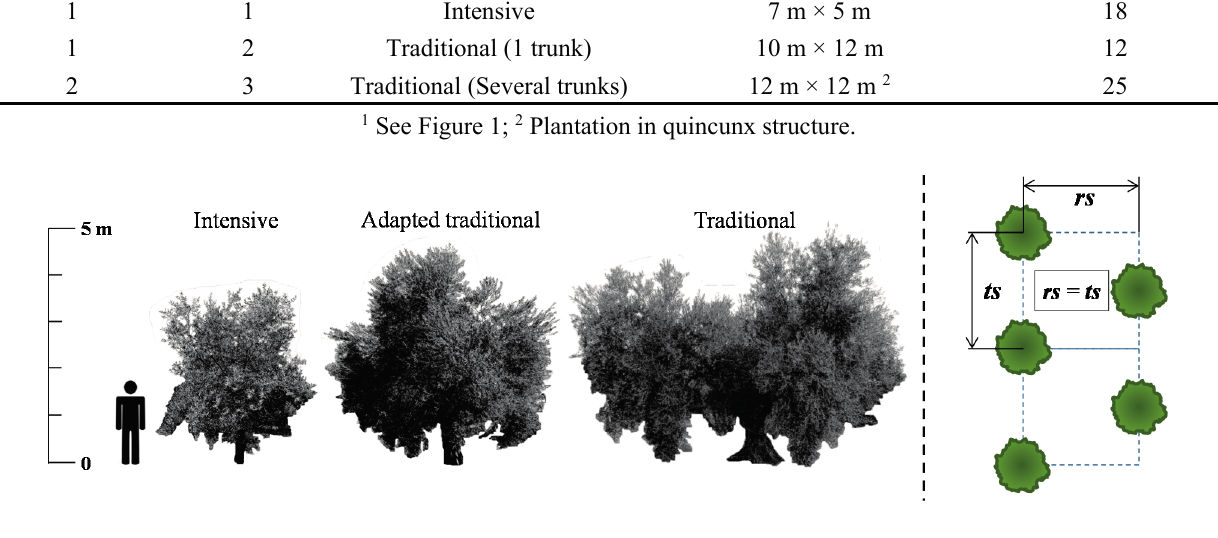
Figure 1. Olive tree types considered for the study ( left ) and the traditional trees distribution pattern ( right